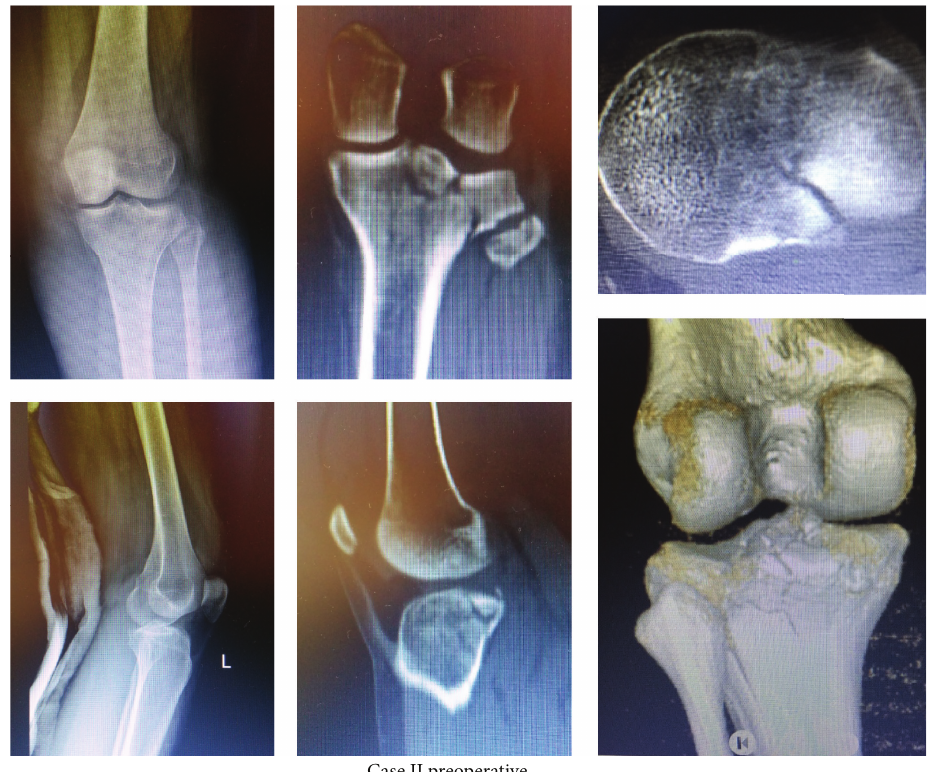
Figure 2: Preoperative radiographies and computed tomography images of Case